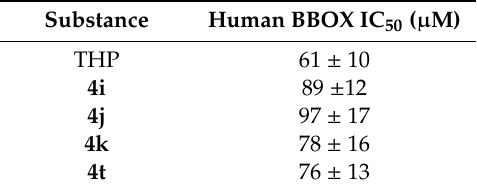
Table 1. The inhibitory e ff ect of TCL on γ -butyrobetaine hydroxylase (BBOX).